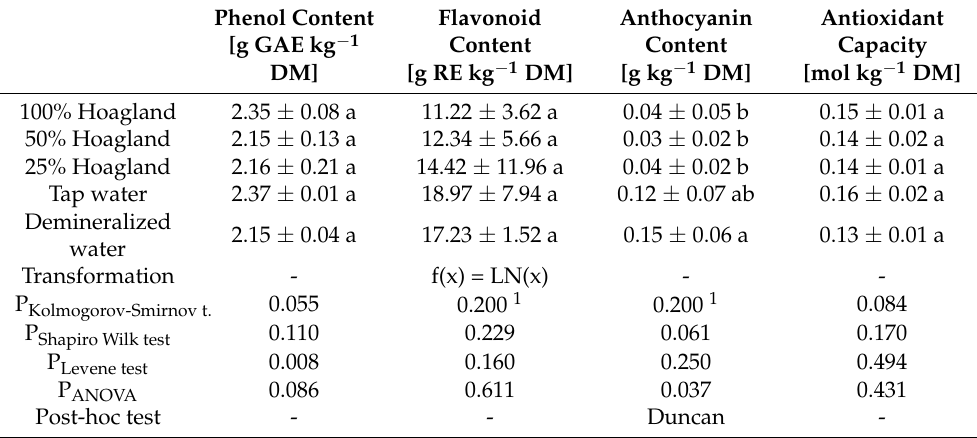
Table 12. Content of phenolic compounds and antioxidant capacity in garden cress in g kg − 1 dry mass (DM) and mol kg − 1 DM, respectively. Different letters within a column indicate significant differences.